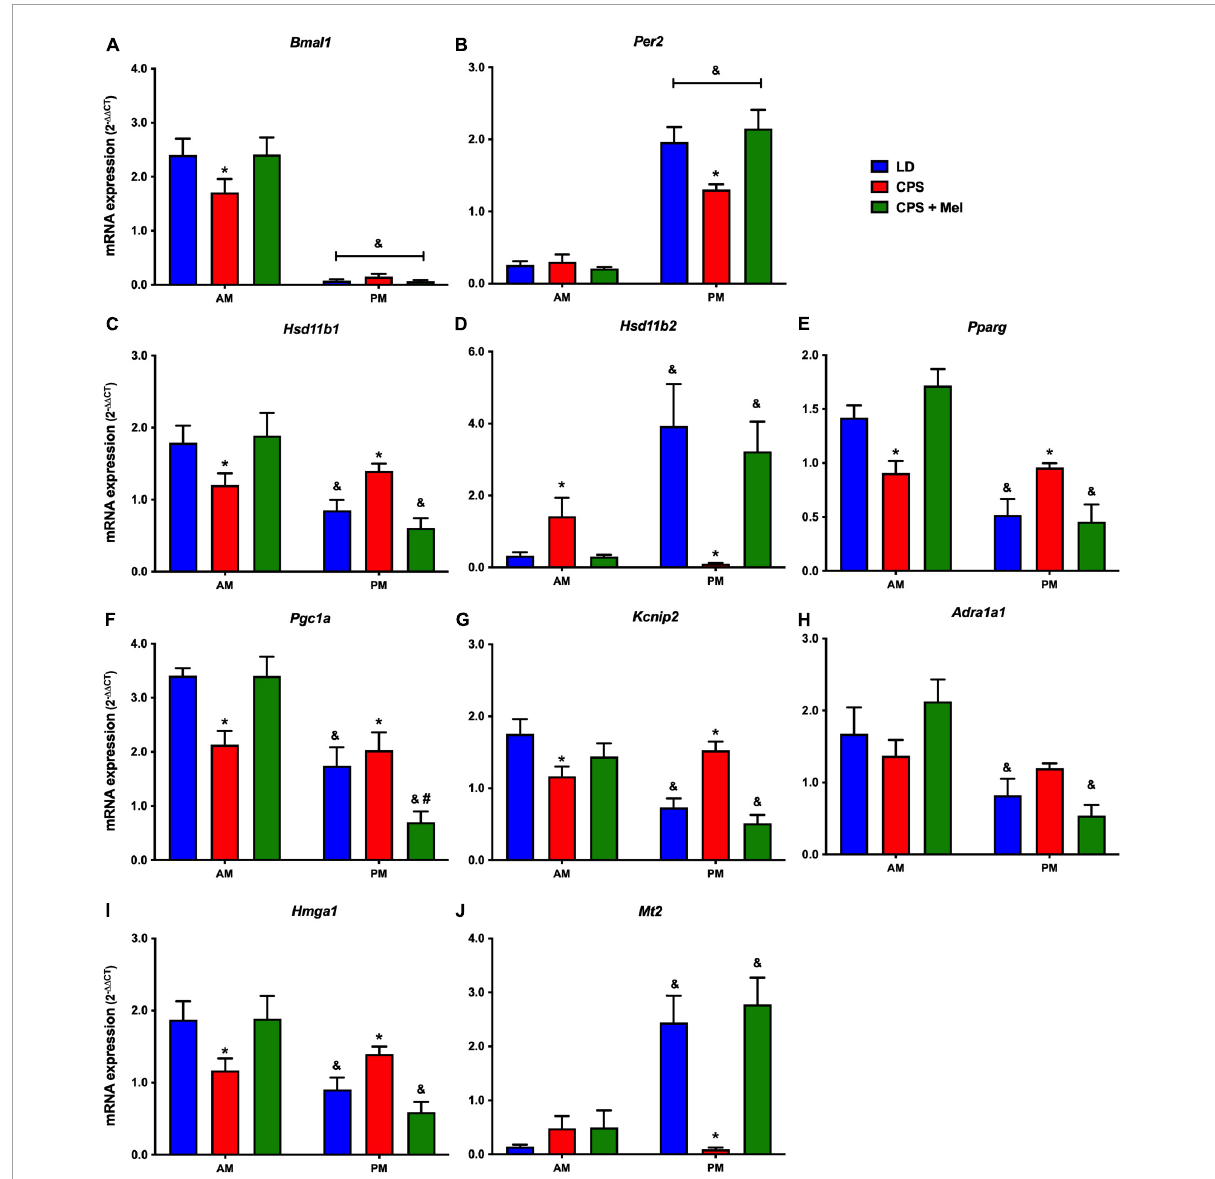
FIGURE4 Gene expression in the heart from adult female offspring. The left ventricle was collected at 11 and 23 h ( n = 6–7 per clock time) in females gestated in LD (blue bars), CPS (red bars), and CPS + Mel (green bars) conditions. Data are mean ± SEM. *Different to LD and CPS + Mel, # Different LD to CPS (two-way ANOVA and Tukey). & Different to AM period (unpaired t -test; two-way ANOVA, and Tukey). Significant differences were ser when p < 0.05.